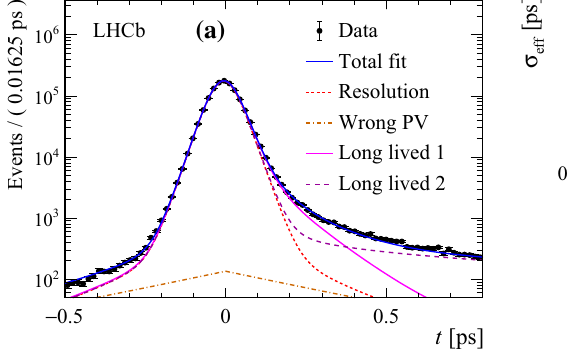
as a function of the estimated per-candidate decay-time uncertainty, δ t , obtained from the prompt J /ψ K + K − sample. The red line shows the result of a linear fit. The data points are positioned at the barycentre of each δ t bin. The shaded histogram (see right y axis) shows the distri- bution of δ t in the background-subtracted B 0 s → J /ψ K + K − sample